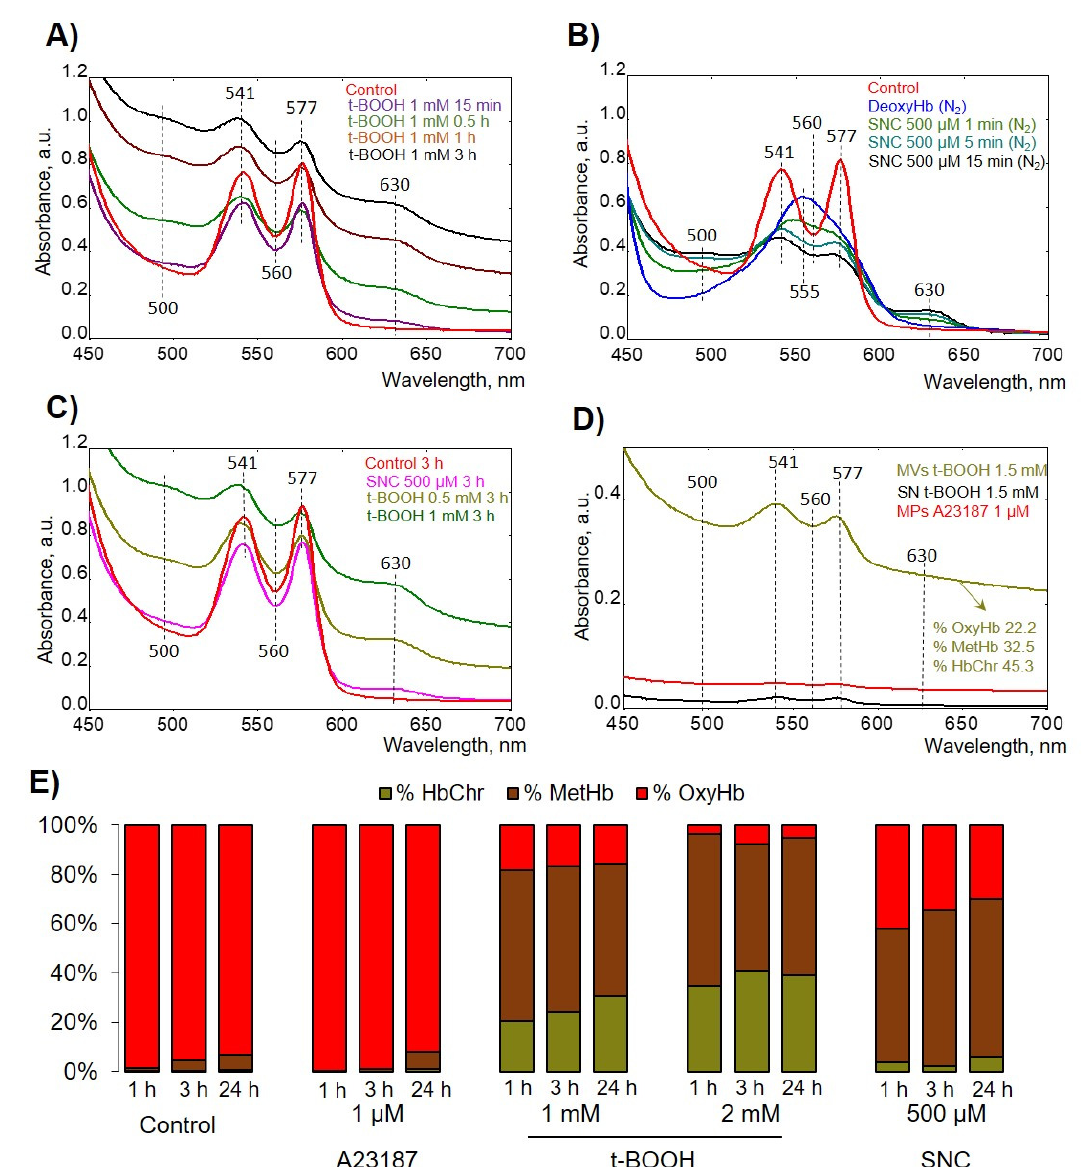
Figure 4. t-BOOH induced hemichrome (HbChr) formation. Spectral scans from 450 to 700 nm captured the di ff erent oxidation states of hemoglobin (Hb) identified by characteristic peaks in the visible region. ( A ) Representative spectra of free Hb oxidation by 1mM t-BOOH (ferric, 500 and 630 nm; ferryl / HbChr, 545 nm, 576 nm, and a flattened region between 600 and 700 nm) in comparison with intact Hb spectra (ferrous, 541 and 576 nm) in HEPES-bu ff er at 25 ◦ C in kinetics. ( B ) Representative spectra of free Hb oxidation by 500 µ M SNC in deoxygenated by N 2 HEPES bu ff er at 25 ◦ C in kinetics. Free oxyHb was deoxygenated by N 2 and then SNC was added for the indicated time. ( C ) Spectra of Hb from hypoosmotically lysed RBCs after 3 h treatment with indicated compounds at indicated concentrations. ( D ) After 24 h of RBC incubation with indicated compounds, we collected the MVs and MPs, as described in the Materials and Methods section, and then MVs / MPs and supernatant (SN) from the last washing step were analyzed. ( E ) Representative bar chart of Hb species calculated from one donor.